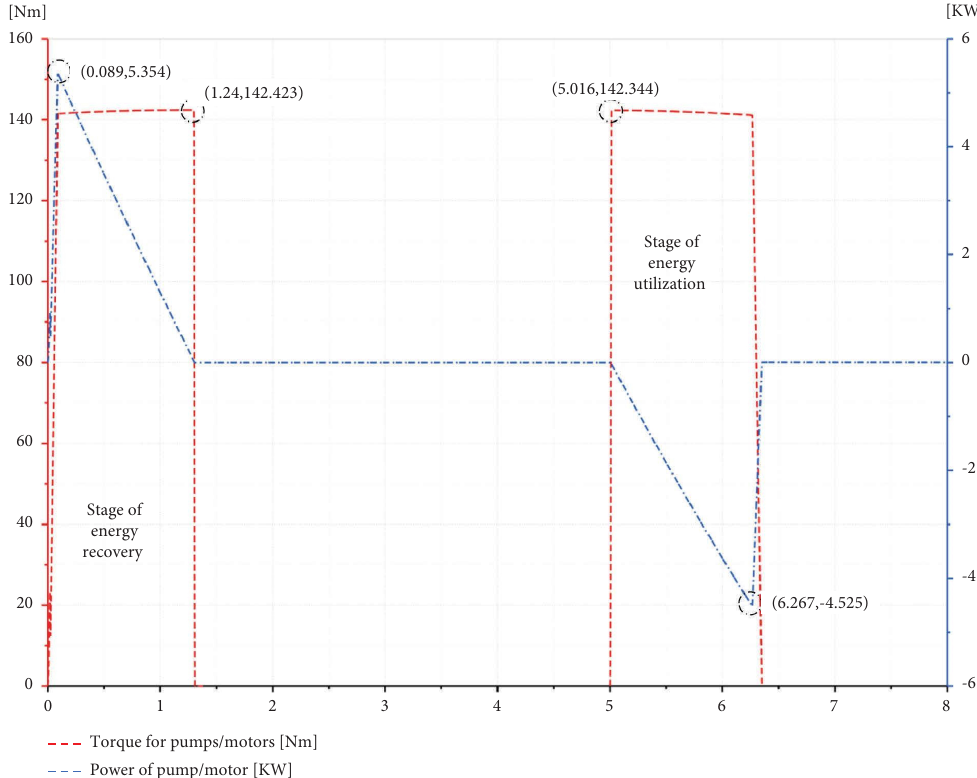
Figure 10: Variations in starting torque, pump/motor braking, and